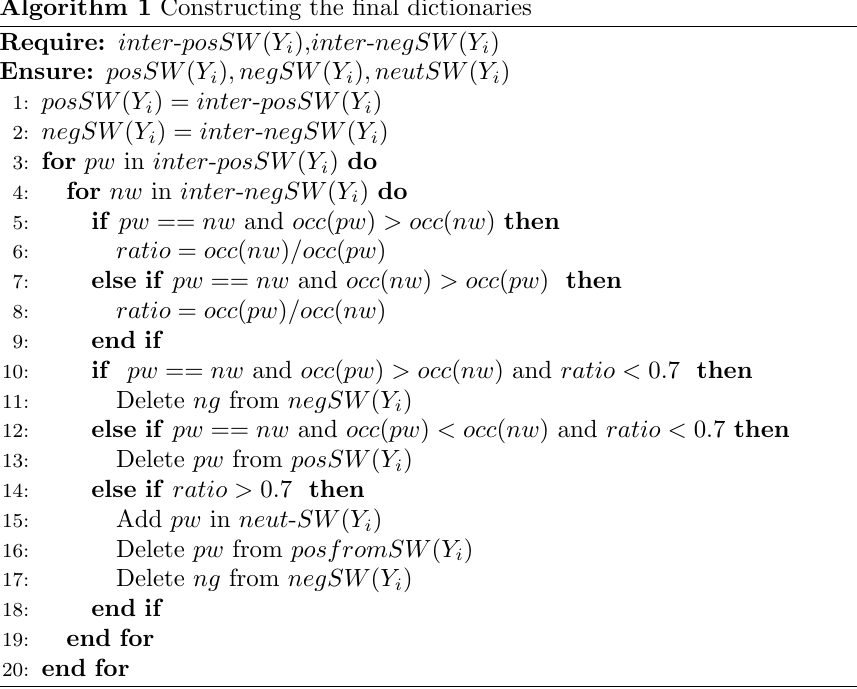
Algorithm 1 Constructing the final